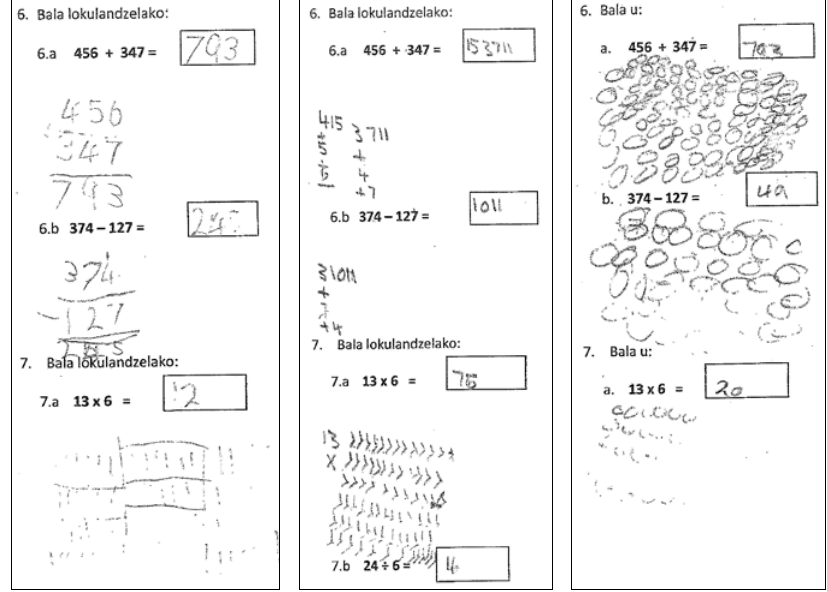
Figure 6: Extract 1 from grade 3 , learners J, K and